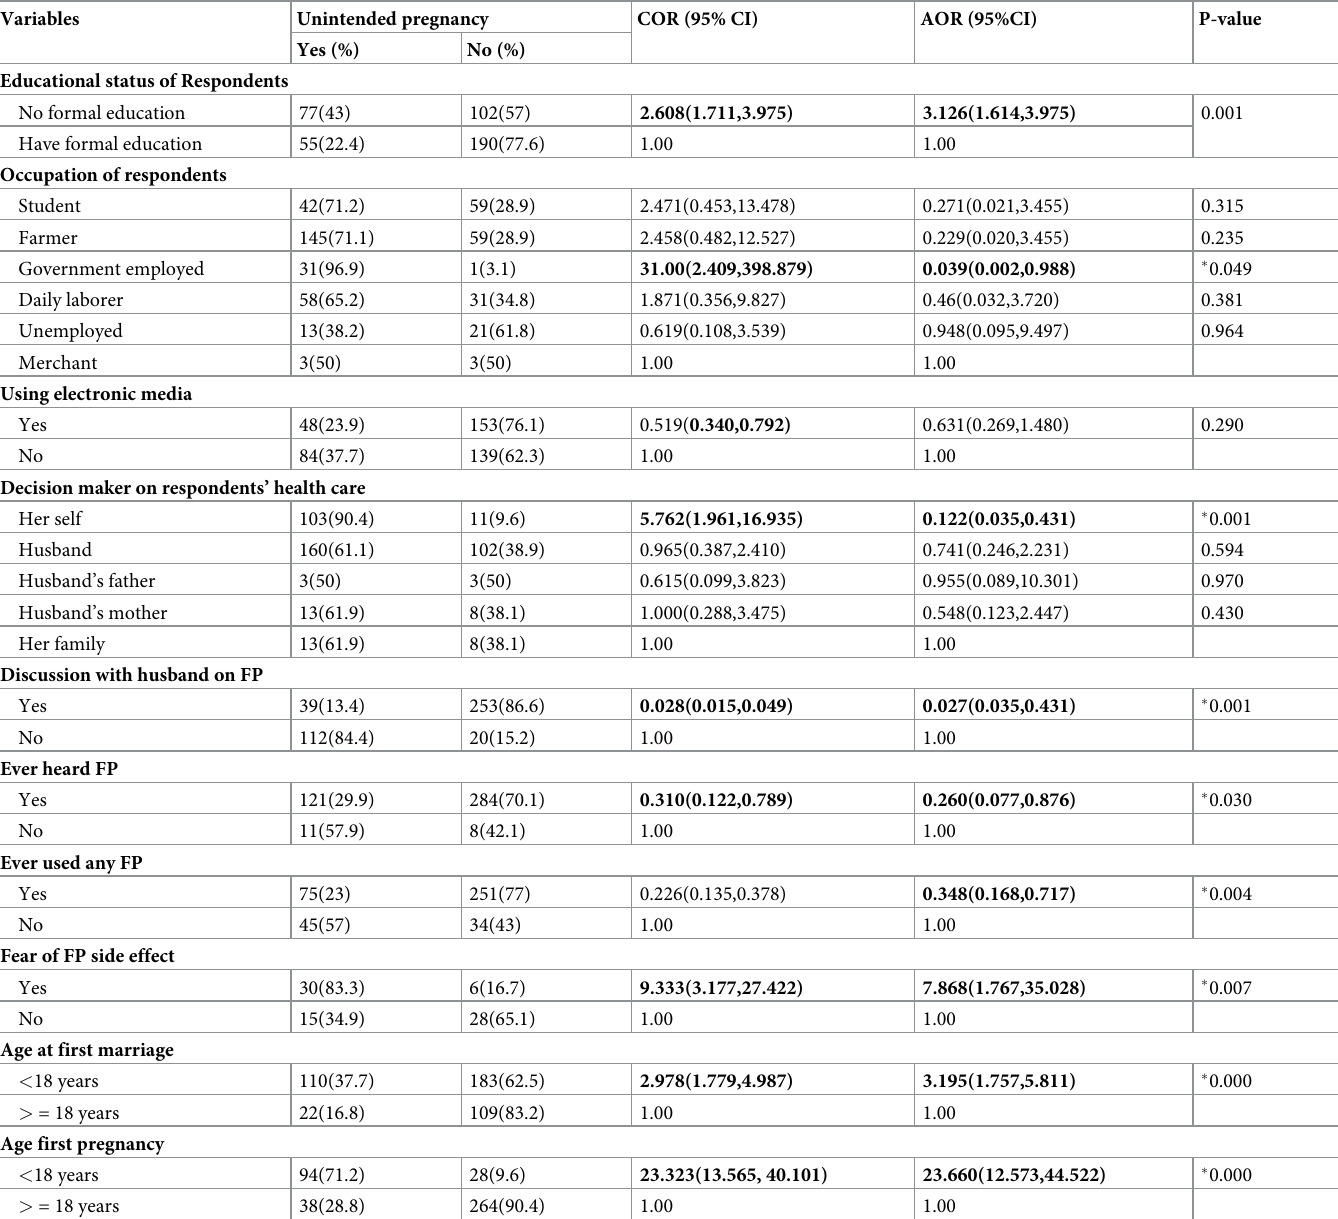
Table 5. Factors associated with unintended pregnancy among youths currently married pregnant women of Kiremu district, Oromia Ethiopia,